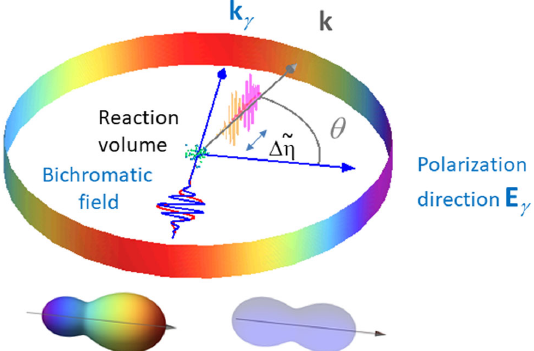
FIG. 1. Scheme of the experiment: Bichromatic, linearly polarized light (red and blue waves), with momentum k γ and electric vector E γ , ionizes neon in the reaction volume. The electron wave packets (yellow and magenta waves) are emitted with electron momentum k . The m -averaged phase difference Δ ˜ η between wave packets created by one- and two-photon ionization depends on the emission angle. The photoelectron angular distribution depends on the relative (optical) ω - 2 ω phase ϕ . Lower figures: Polar plots of photoelectron intensity at E 16 . 6 eV for coherent harmonics (asymmetric, colored plot) and incoherent harmonics (symmetric, gray plot).